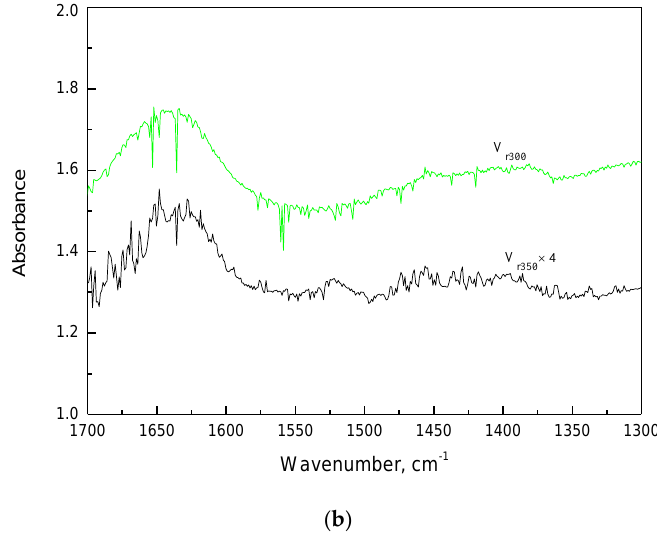
Figure 3. ( a ) FT-IR spectra in the region of 2700–3400 cm −1 for V r300 (green), V r350 (black), V r400 (red), and V r450 (blue). ( b ) FT-IR spectra in the region of 1300–1700 cm −1 for V r300 (green) and V r350 (black). As the regeneration temperature increased from 300 to 450 °C, the decrease in peak intensity indicates a decrease in carbonaceous species formed on the adsorbents. The de- crease in I CH3 /I CH2 suggests oligomer formation, and its chain length increased with tem- perature. Compared with the CH 3 and CH 2 bending vibration frequency (1370–1450 cm −1 ) for V r300 , the shift to a higher frequency (1390–1480 cm −1 ) for V r350 is consistent with the decrease in I CH3 /I CH2 . The peak at 1520 and shoulders at 1480 and 1610 cm −1 for V r350 suggest the formation of some alkylated aromatic coke from oligomers [36,38,40]. No significant peaks were observed at 3000−3200 and 1540–1560 cm −1 regions, indicating that there was no significant polycyclic aromatic coke formed via hydrogen transfer reaction in air re- generation